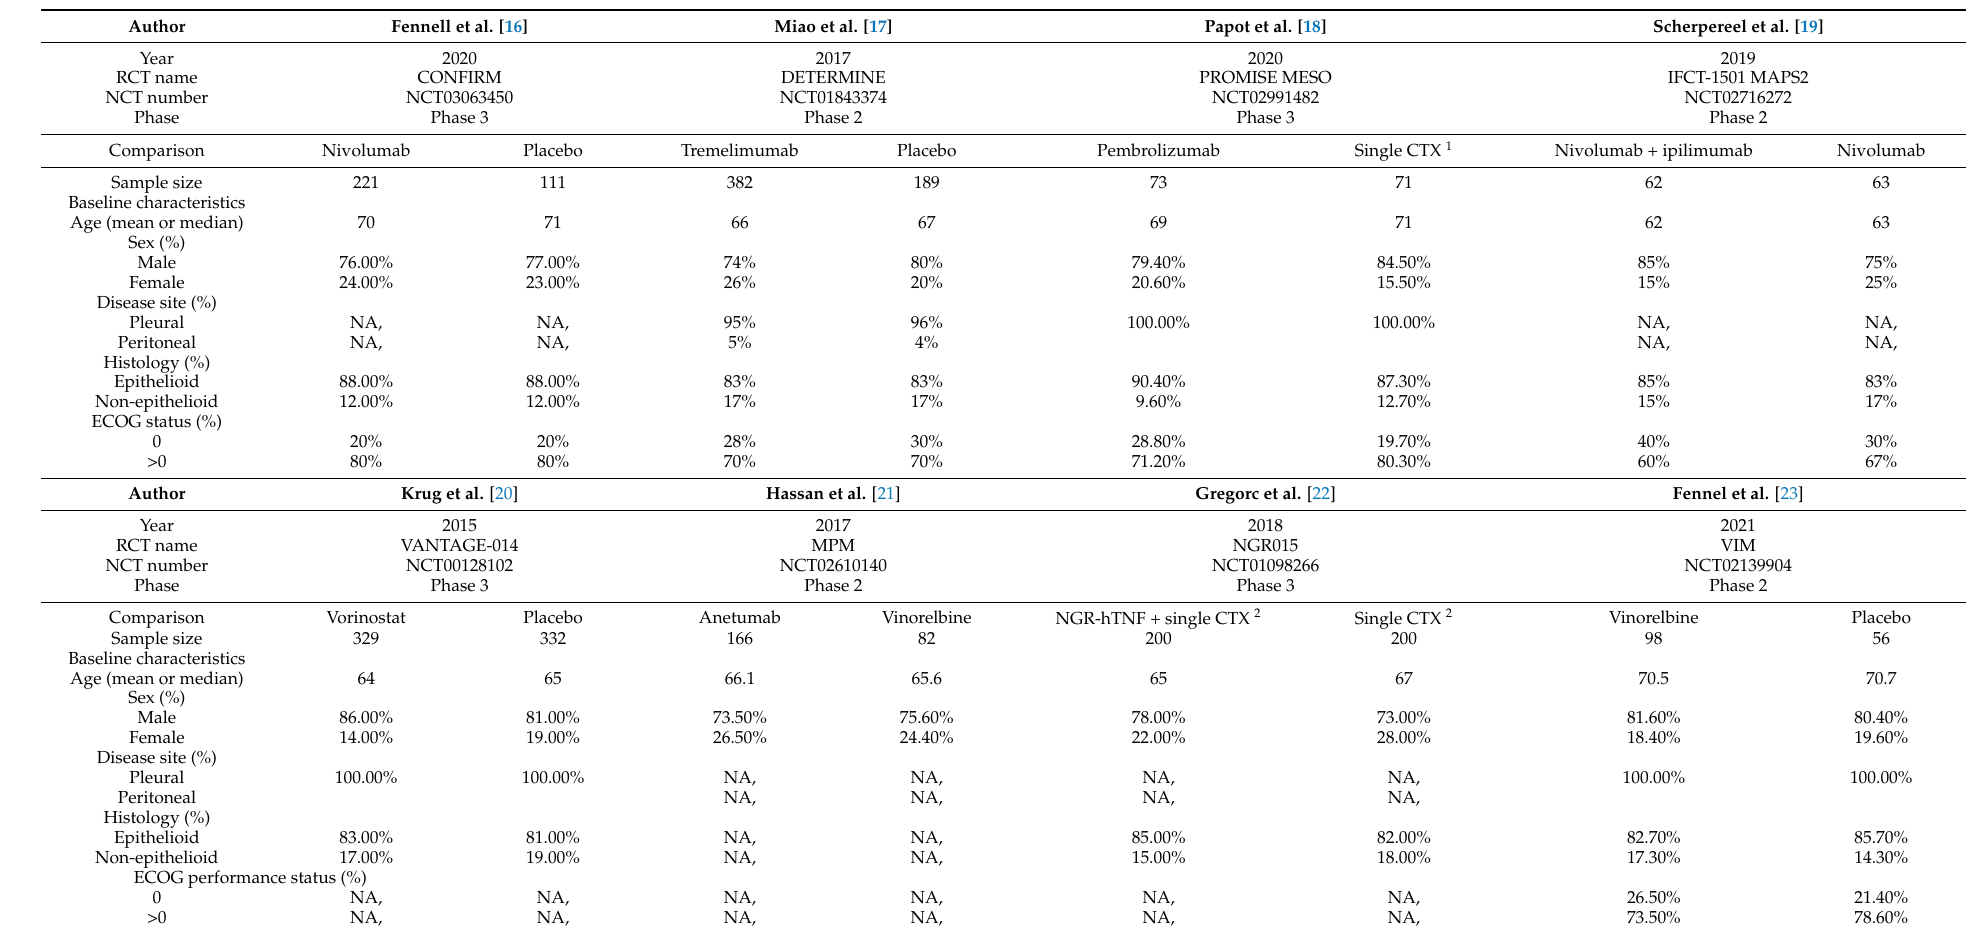
Table 1. Characteristics of the included